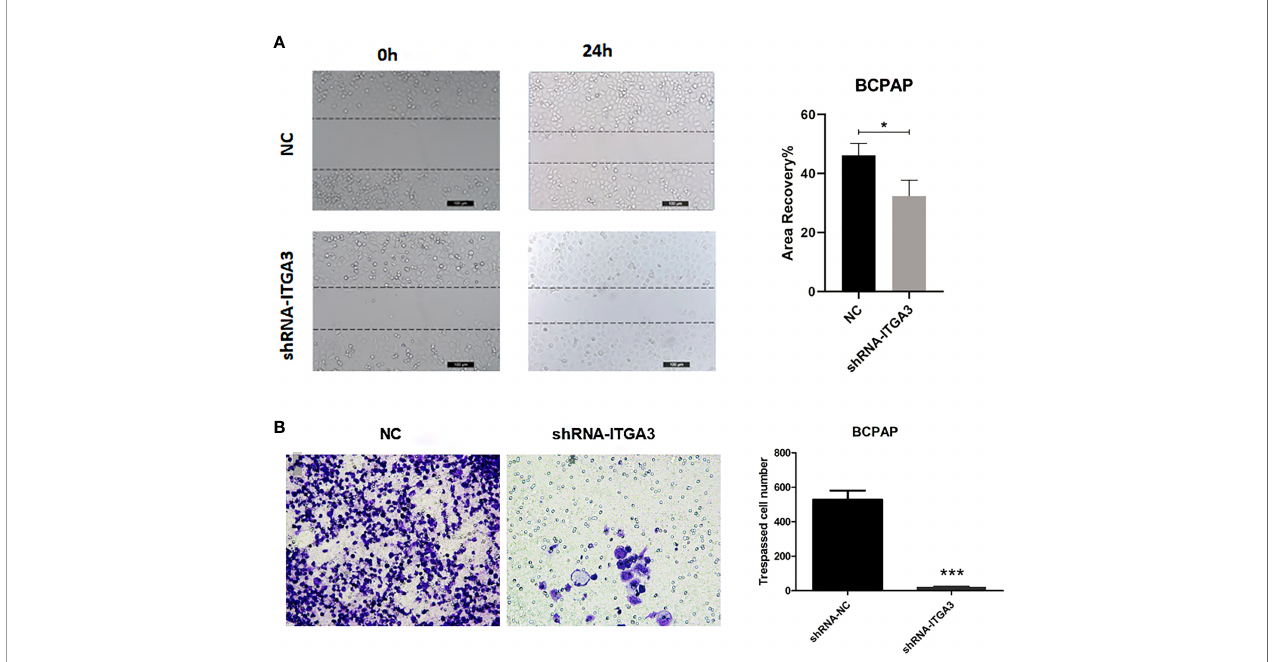
FIGURE 11 | The knockdown of ITGA3 levels signi fi cantly inhibits the capacity of migration and invasion of renal cancer cells in vitro . (A) Wound scratch assay analysis of the impact of ITGA3 knockdown on cell migration (***P < 0.001, *P < 0.05, compared with the respective control). (B) Transwell assay analysis of the impact of ITGA3 knockdown on cell invasion of PTC cell